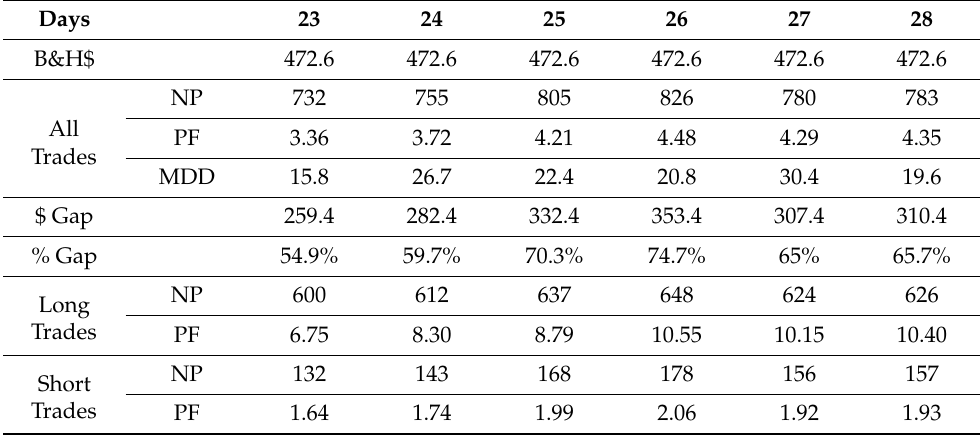
Table 4. Results for Binance Coin